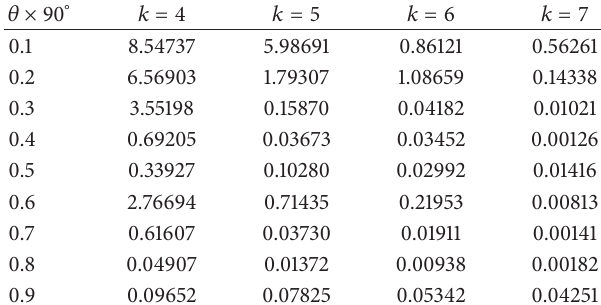
Table 3: The absolute errors between reproduced RCS and original RCS for different 𝑘